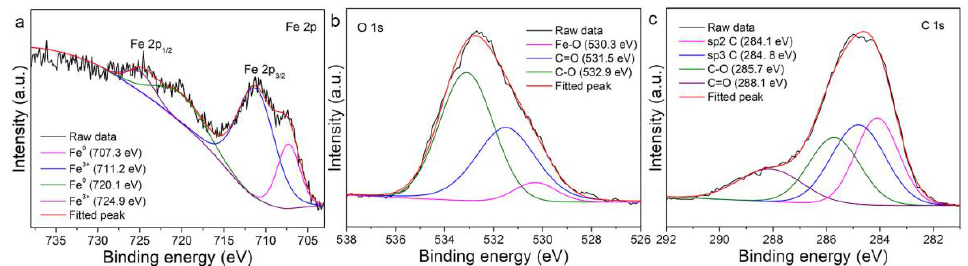
Figure 5. Raman spectrum of the particles obtained by the laser ablation in liquids (LAL) of Fe in acetone.